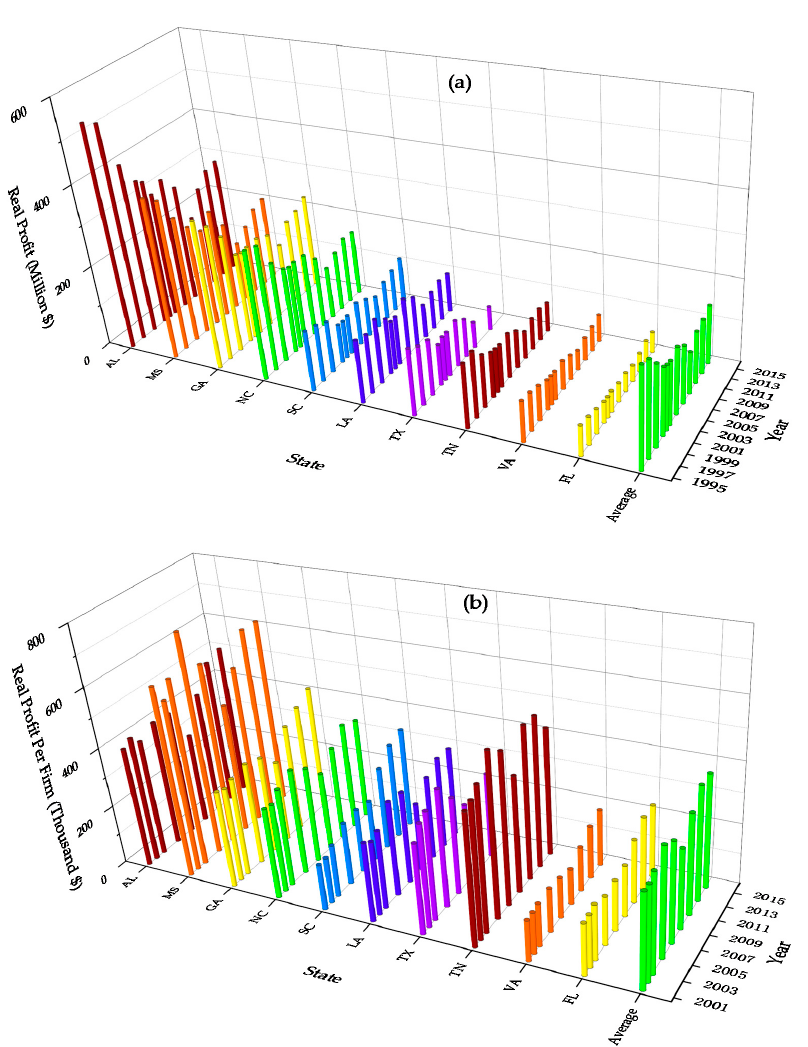
Figure 3. Inflation-adjusted ( a ) net profits of the logging industry at state level and ( b ) net profits per logging firm in some states from 1995 to 2015, based on the EIO-LCA models (2019 Constant- dollar) [38,71]. Notes: AL, MS, GA, NC, SC, LA, TX, TN, VA, and FL signify Alabama, Mississippi, Georgia, North Carolina, South Carolina, Louisiana, Texas, Tennessee, Virginia, and Florida, respectively.